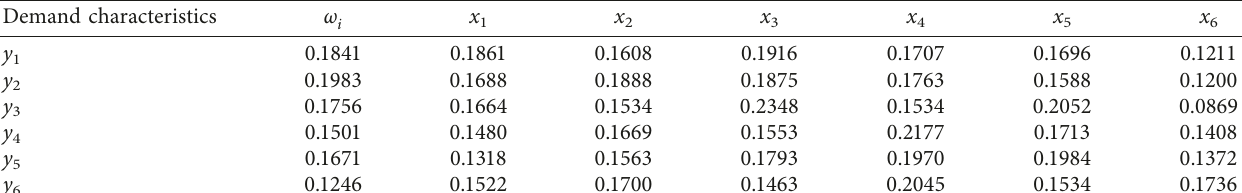
Table 5: Quality of House for CA6140 lathe.